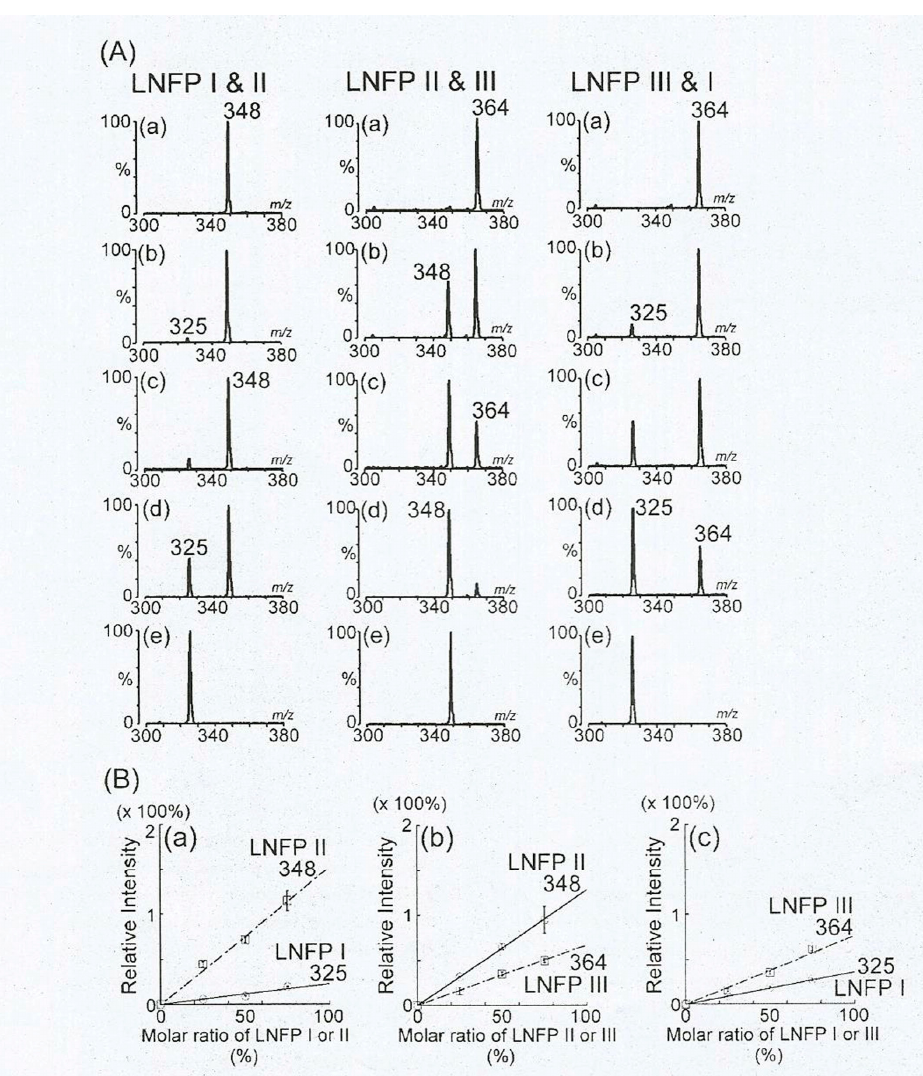
Figure 19. Expanded PSD (postsource decay) spectra ( A ) and the calibration curves ( B ) of the mixtures of LNFP-I and LNFP-II; LNFP-II and LNFP-III; and LNFP-III and LNFP-I. The molar ratios of the isomers in the analyte mixtures of the PSD spectra ( A ) are 0:100 ( a ), 25:75 ( b ), 50:50 ( c ), 75:25 ( d ) and 100:0 ( e ). The calibration curves of LNFP-I and LNFP-II are in ( a ) in ( B ), that of LNFP-II and LNFP-III are in ( b ) in ( B ) and that of LNFP-III and LNFP-I are in ( c ) in ( B ). Reproduced with permission from